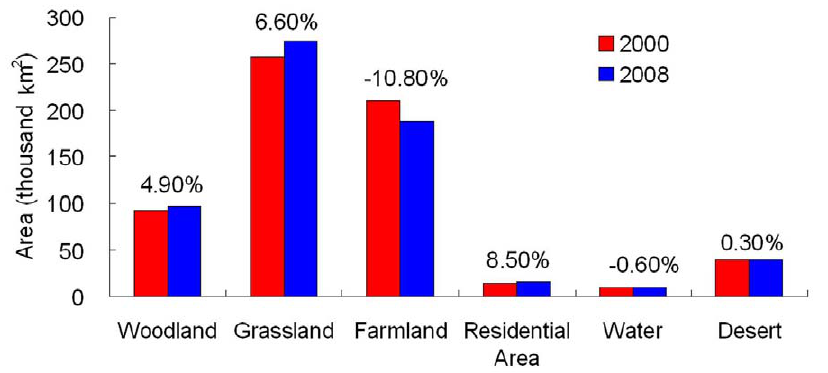
Figure 2. Coverage of each land cover type in the Loess Plateau, in 2000 and 2008. Numbers above bars indicate the change in area covered in 2008 as compared to 2000.